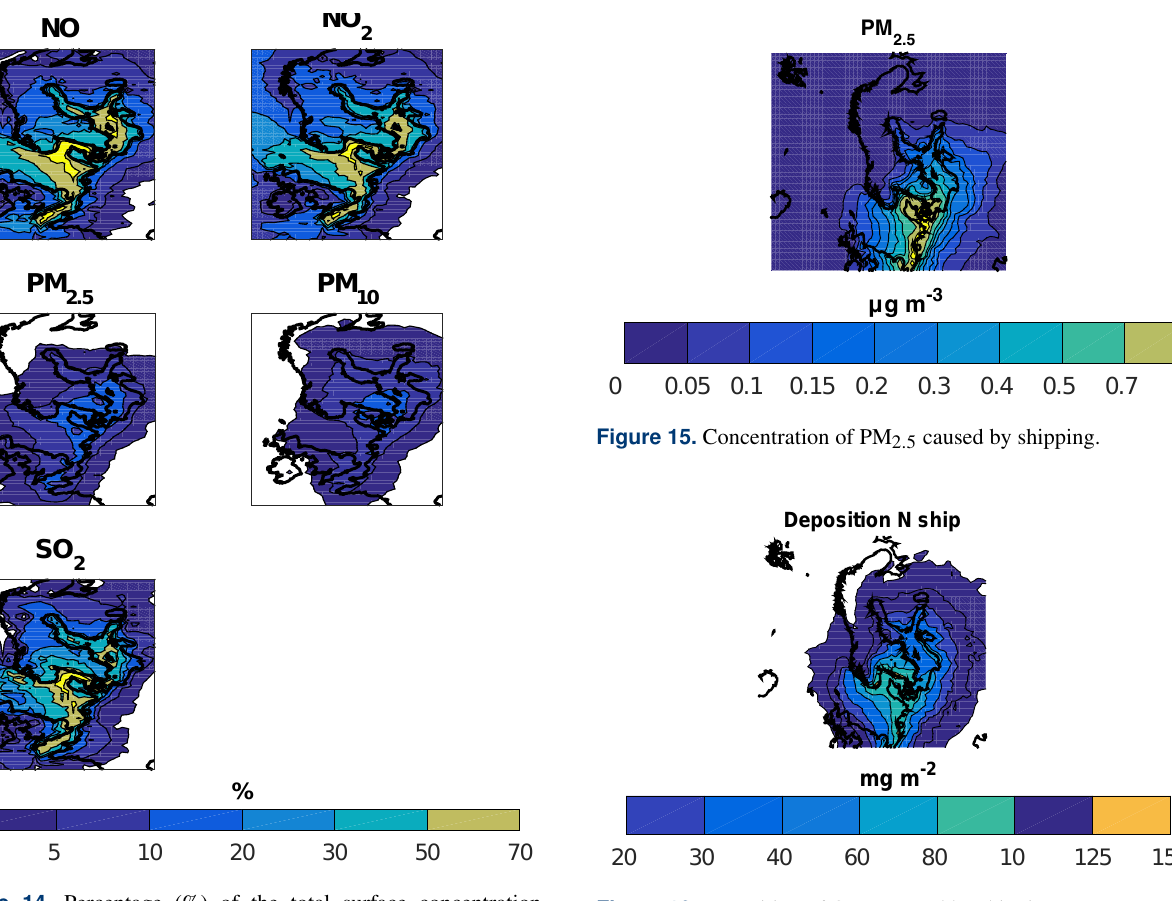
Figure 16. Deposition of OXN caused by